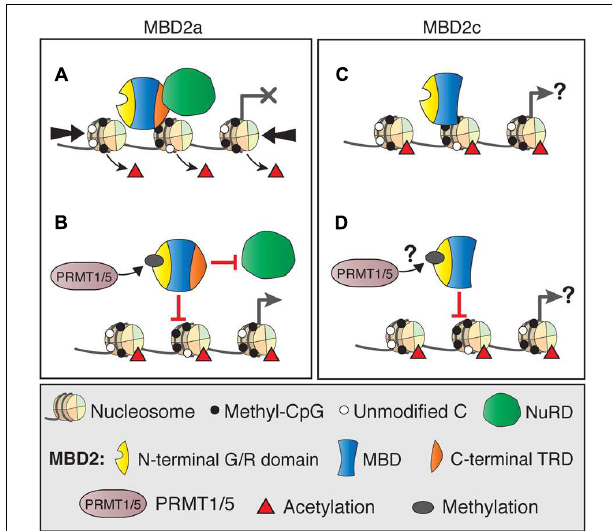
FIGURE 6 | DNA binding dynamics of MBD2 isoforms depend on post-translational modifications. (A) MBD2a and NuRD binding to methylated sites results in nucleosome remodeling (thick arrows) and deacetylation (red triangles), producing transcriptional silencing. (B) Post-translational methylation of the N-terminal glycine/arginine rich region of MBD2a by PRMT1/5 reduces the affinity of MBD2a for NuRD and methylated DNA and may not produce transcriptional repression. (C) MBD2c does not interact with the NuRD complex but does bind methylated DNA. It is not fully understood how this binding may affect transcriptional regulation. (D) MBD2c has the N-terminal G/R rich domain, but it is not clear if it is also methylated by PRMT1/5 and if this modification would affect DNA binding similarly to